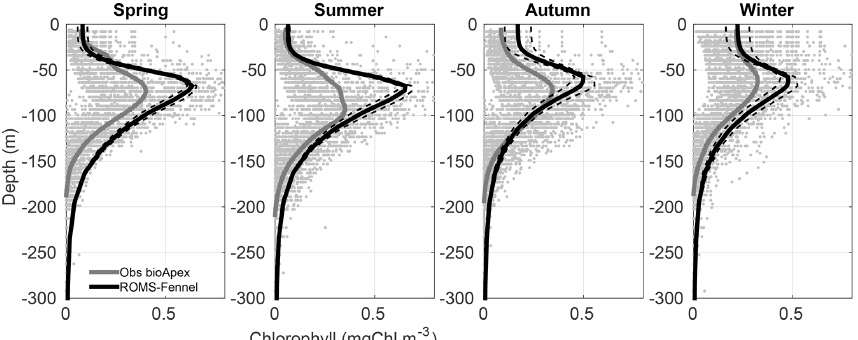
Figure A4. Seasonal comparison of chlorophyll profiles in milligrams of chlorophyll per cubic metre, taking all the available Apex floats (Pasqueron de Fommervault et al., 2015), in order to evaluate the deep chlorophyll maximum (DCM). Grey dots are the data observed from Apex floats; the average profile is shown in grey. In black is the averaged profile of the model data with its respective standard deviation in dashed black lines.